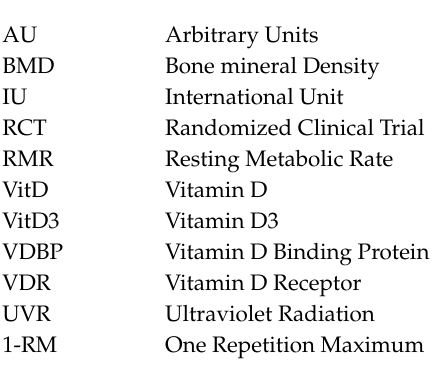
s1, Figure S1: Mean ± (SD) Daily total energy (A) and macronutrient intake (B, C and D) pre-, mid- and post-supplementation in the placebo and VitD3 groups., Table S1: Theoretical method to calculate the percentage of free 25(OH)D availability